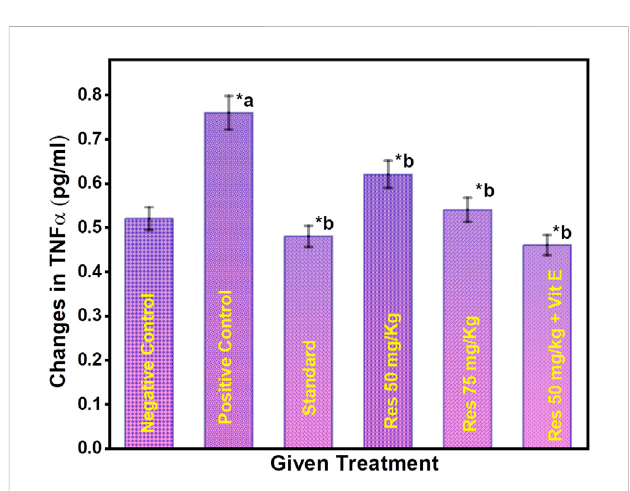
FIGURE 6 Changes in TNF- α levels after different treatments. a negative control vs. positive control; b positive control vs. treatment